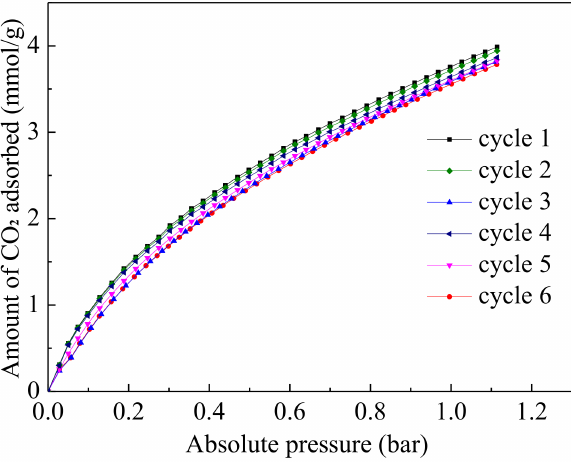
Figure 11. Six cycles of CO 2 adsorption isotherms on UiO-66-NH 2 /GO at 298